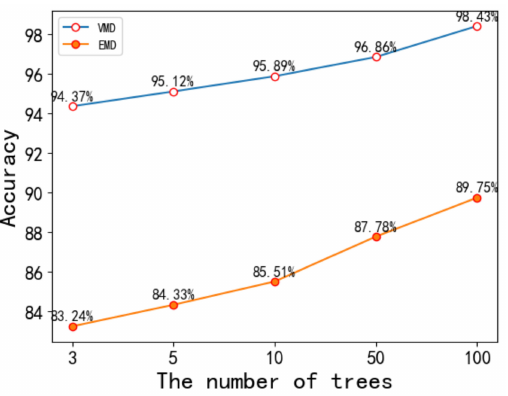
Figure 5. Classification accuracy of the VMD and EMD algorithms with different numbers of random forest